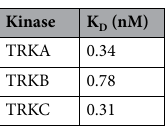
Table 1. Pz-1 binding to TRK kinases. K D of Pz-1 for the indicated kinases.